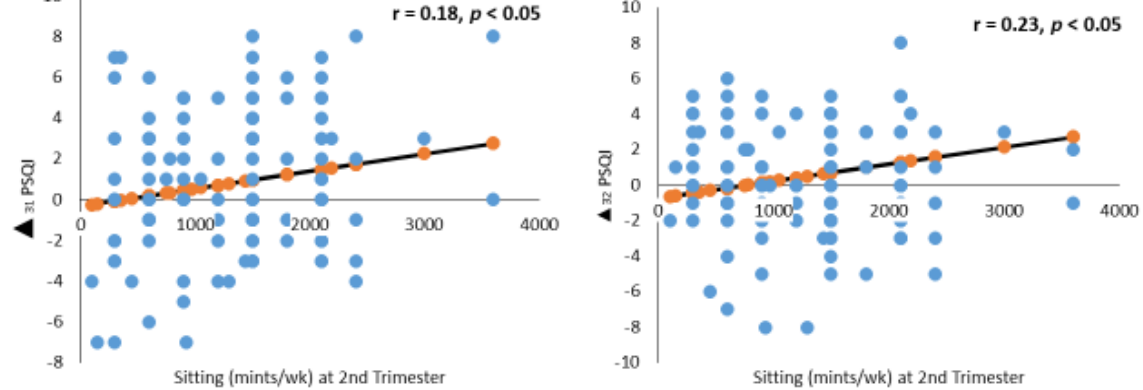
Figure 4. Sitting (minutes/week) in relation to changes in Pittsburgh Sleep Quality Index (PSQI) score across pregnancy. PSQI ∆ 31 , ∆ 21 , and ∆ 32 indicate changes in the PSQI score from the 3rd to the 1st, 2nd to 1st, and 3rd to 2nd trimester.